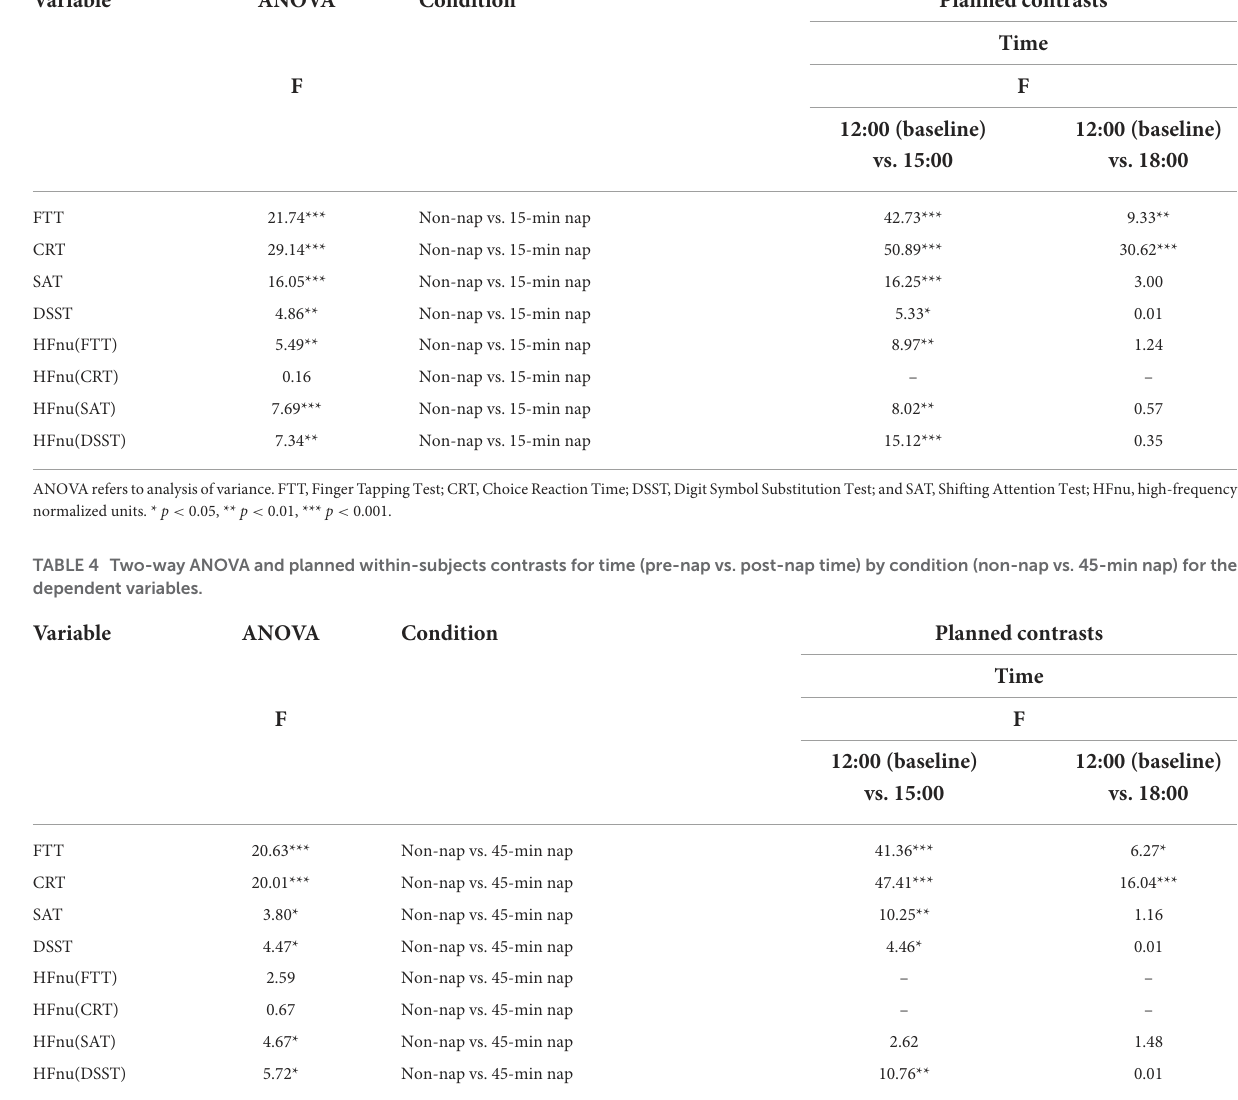
TABLE 3 Two-way ANOVA and planned within-subjects contrasts for condition (non-nap vs. 15-min nap) by time for the dependent variables. Variable ANOVA Condition Planned contrasts